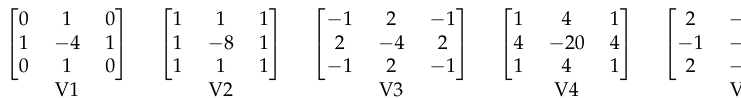
Figure A3. 5 × 5 kernels masks.